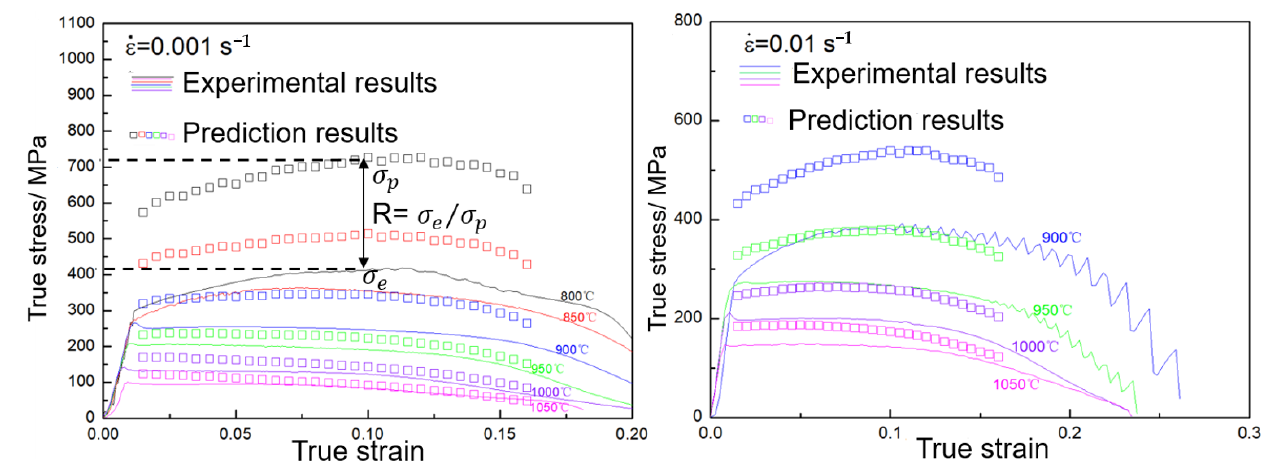
Figure 14. The prediction results of the DRX, DRV and TRV types by the Arrhenius model. The R-values of all TDRV, DRV and DRX curves are shown in Table 2. The R-value rises with increasing temperatures and decreasing strain rate. Moreover, the R-value basically remained unchanged along with the strain rate at a strain rate of 0.001–0.1 s − 1 , which implies that the R-value is only dependent on the temperature in this range. However, the R-value displayed great changes at a strain rate range of 1–10 s − 1 , which demonstrates that the R-value is dependent on both the temperature and temperature in the range. Table 2. The R-value at different temperatures and strain rates.